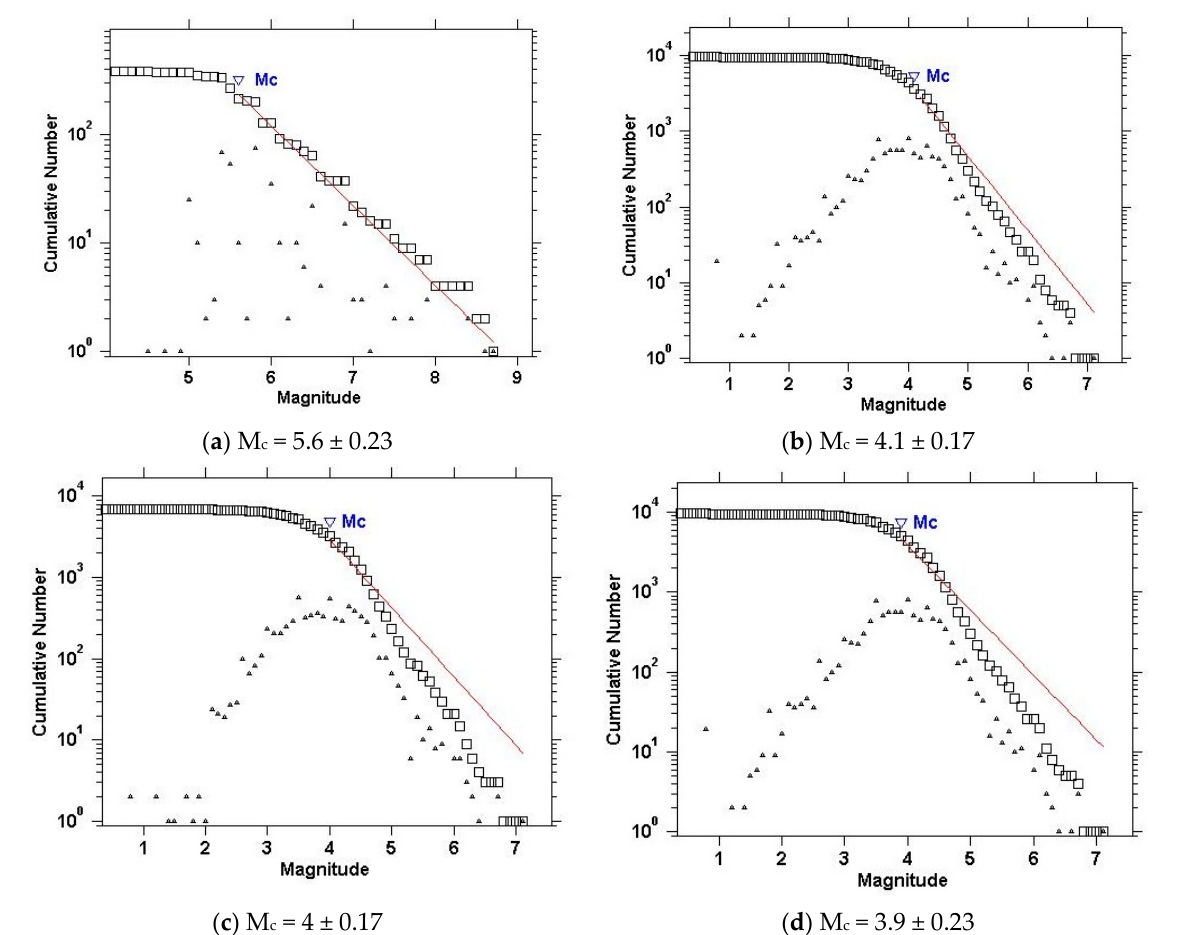
Figure 17. Four different plots showing the cumulative number of earthquake events vs. magnitudes greater than the corresponding magnitude for the following catalog time periods ( a ) 1737–1963, ( b ) 1964–1990, ( c ) 1964–2000, and ( d ) 1964–2012. In addition, these plots show M c values determined by the EMR technique.